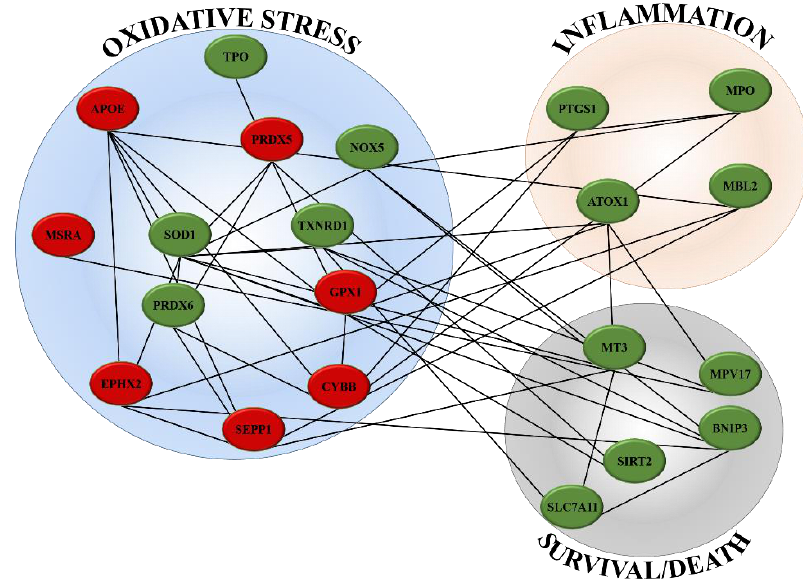
Figure 3. In silico prediction of interaction network of differentially expressed genes. The network was created using the STRING database and GeneMANIA web site (green nodes represent up-regulated genes and red nodes represent down-regulated genes).